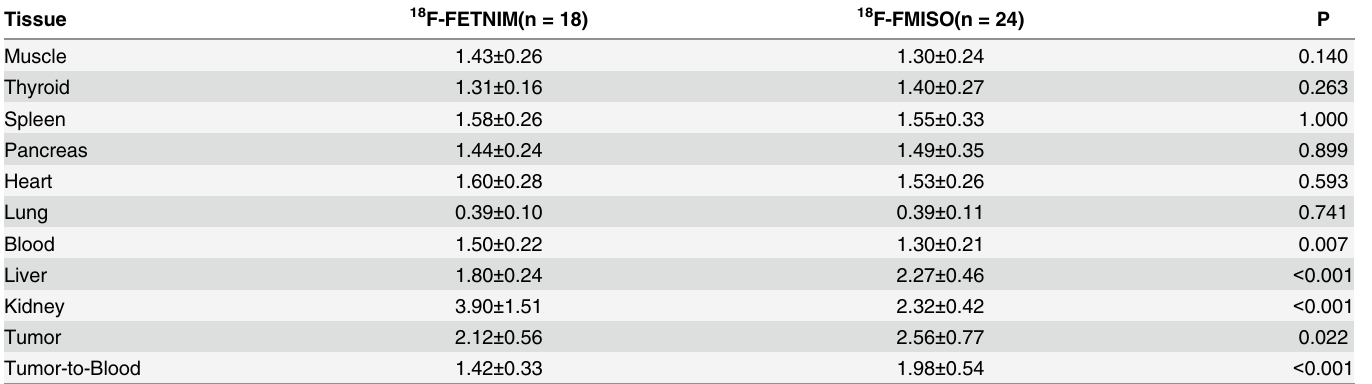
Table 2. Biodistribution of 18 F-FETNIM and 18 F-FMISO on PET/CT in Patients with Lung Cancer. Tissue 18 F-FETNIM(n = 18) Muscle